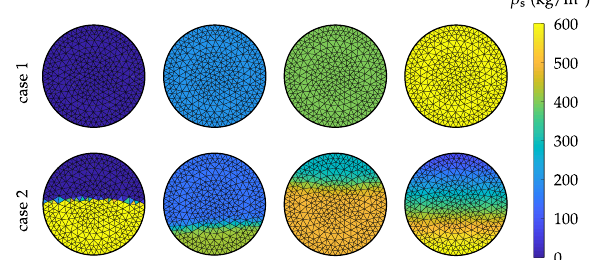
Figure 6. Exemplary random samples for both cross-sectional cases of horizontal pneumatic convey- ing flow patterns. The different mass concentrations result from the different aerated states of the transport good caused by the gas stream of the pneumatic conveying